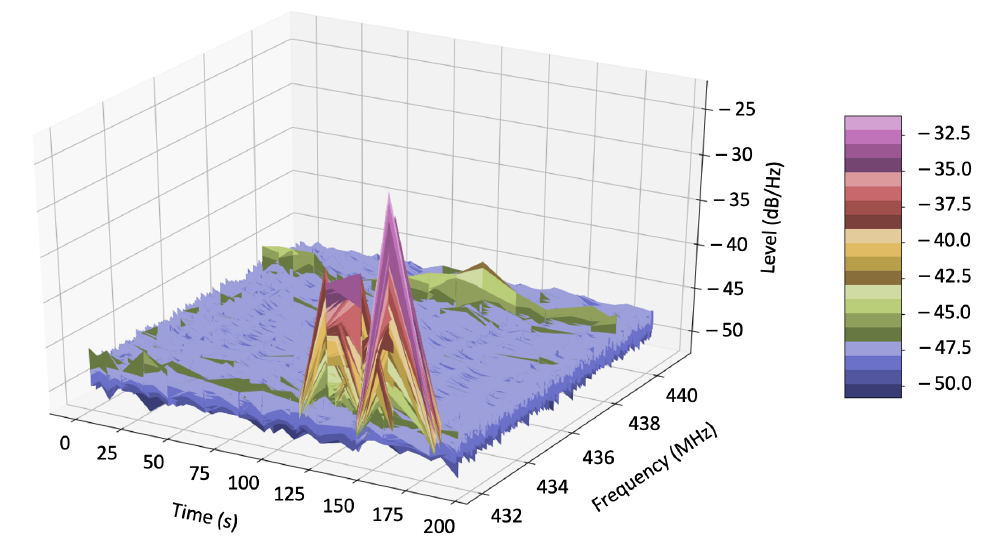
Figure 10. Data collected using the CR platform. It shows a map of the level in dB measured within the frequency range from 432 MHz to 441 MHz throughout the